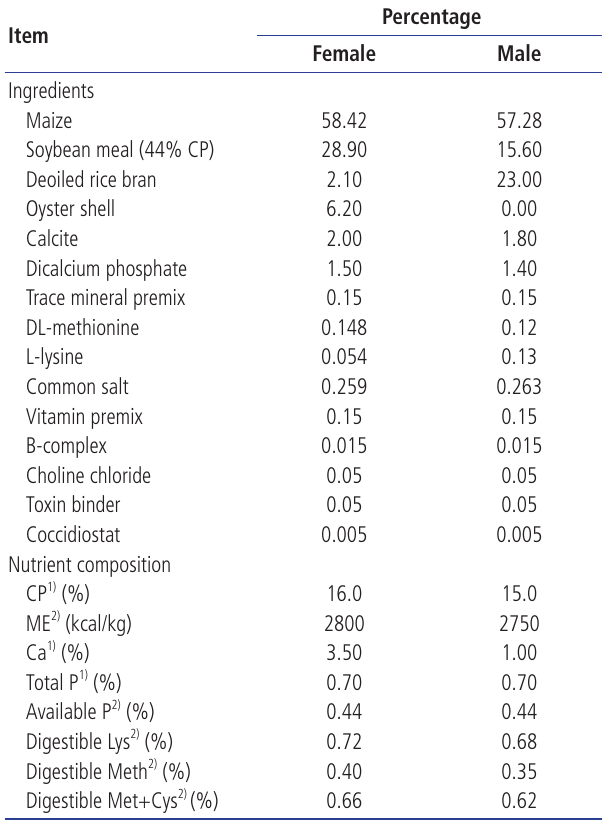
Table 1. Ingredients and nutrient composition of basal diet (DM